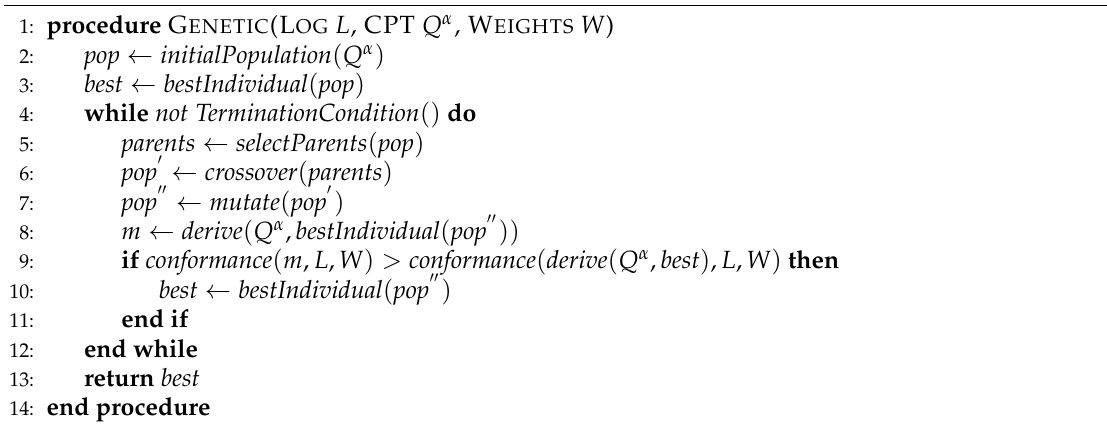
Algorithm 2 Obtain a configuration based on the genetic